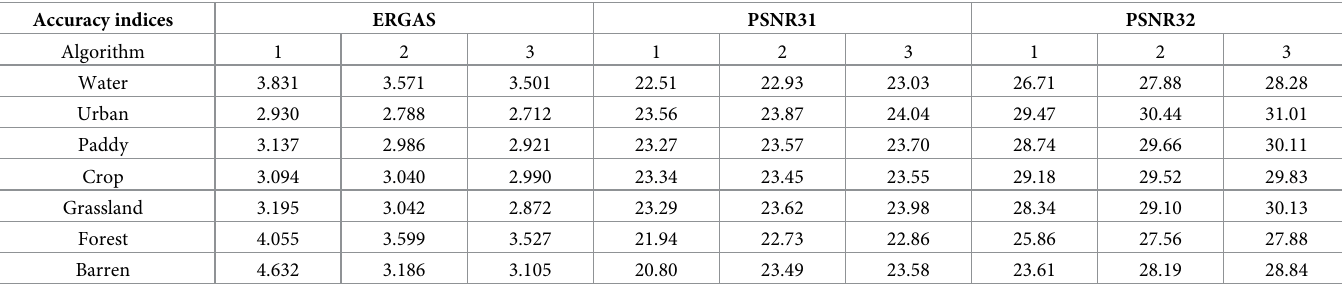
Table 5. Comparison of accuracy indices (ERGAS: Smaller is better; PSNR: Greater is better) for different algorithms and land-cover types. Accuracy indices ERGAS PSNR31 PSNR32 Algorithm